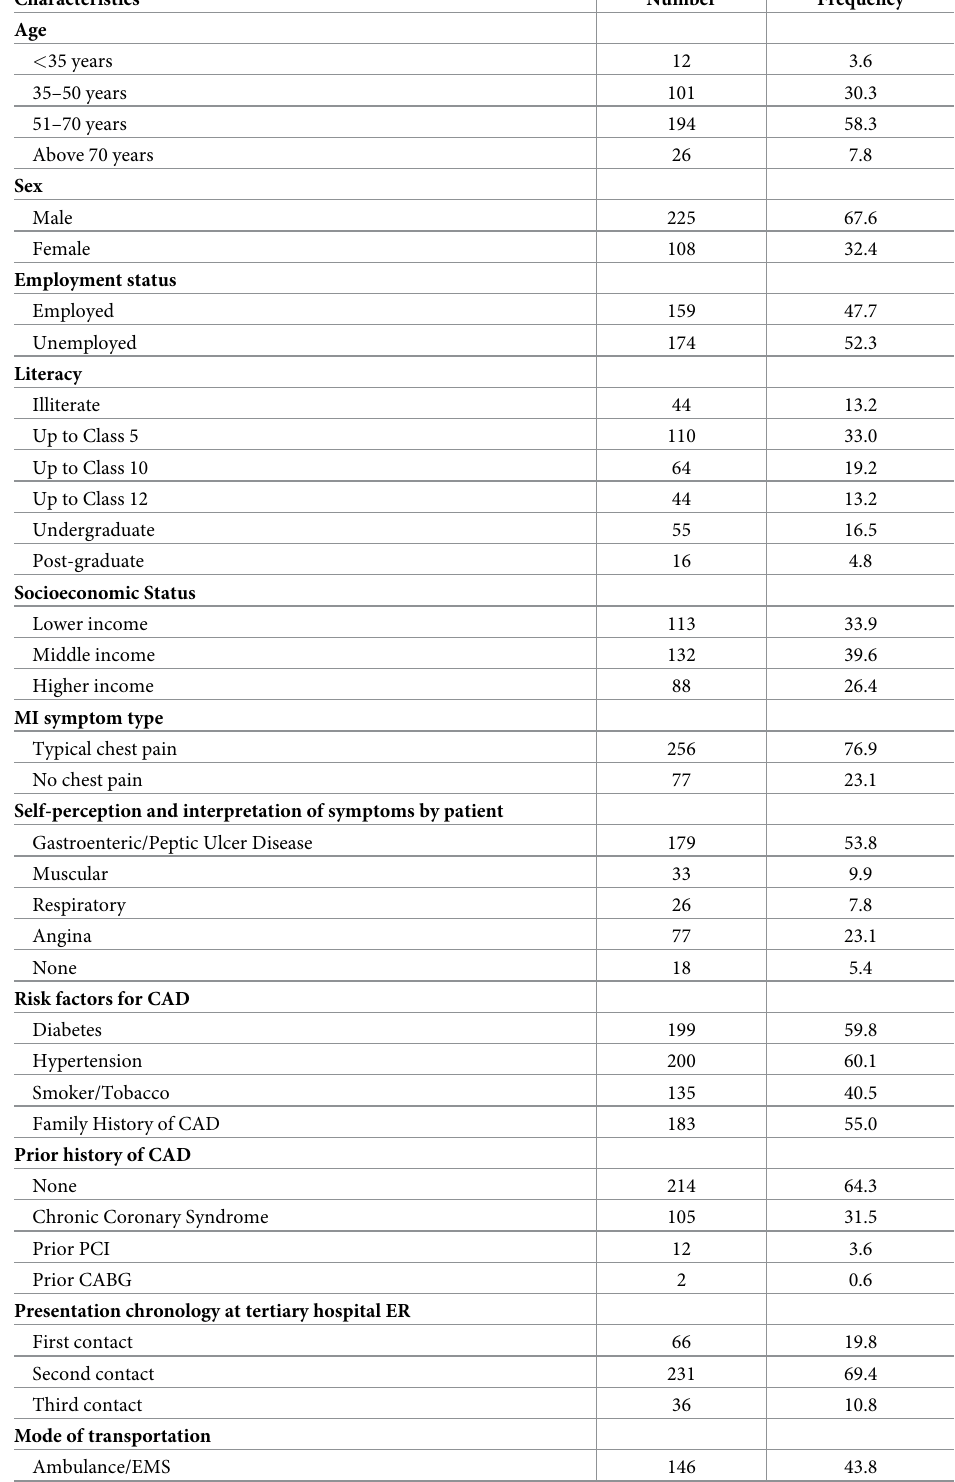
Table 1. Demographic and basic clinical